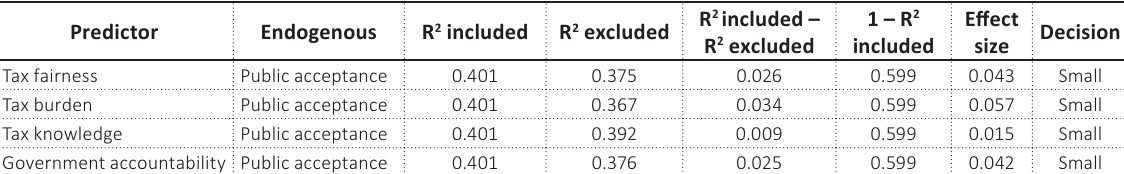
Table 7. F-squared (f 2 ) effect size